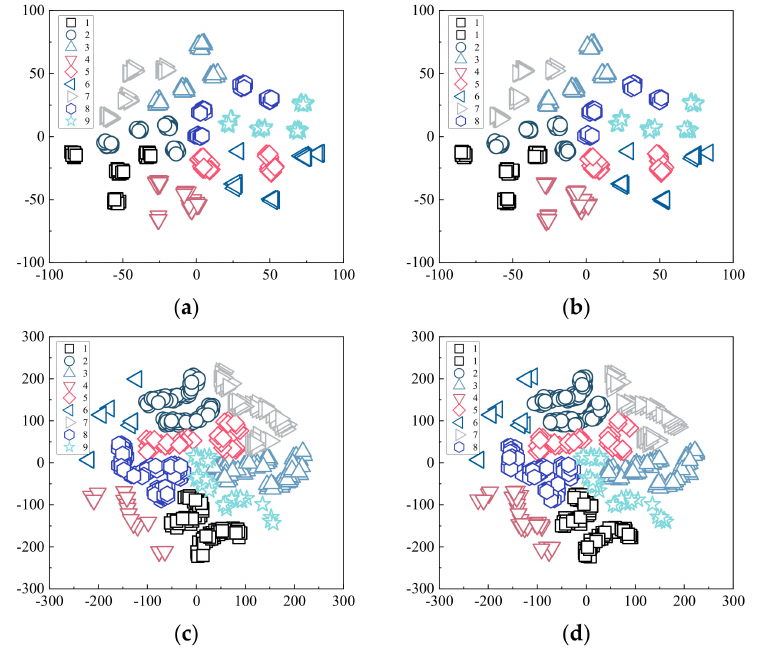
Figure 15. T − SNE visualization of fault features: ( a ) time-frequency signal of the source domain; ( b ) time-frequency signal of the target domain; ( c ) feature embedding of the source domain derived from DANN; ( d ) feature embedding of the target domain derived from